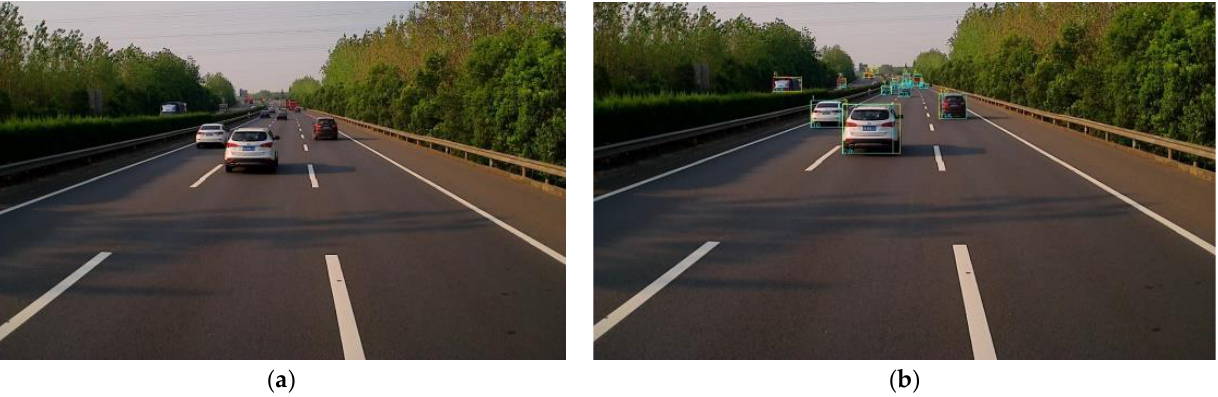
Figure 2. Comparison between the raw mono camera image and the result after the object detector. ( a ) is the raw image; ( b ) is the detected vehicle.